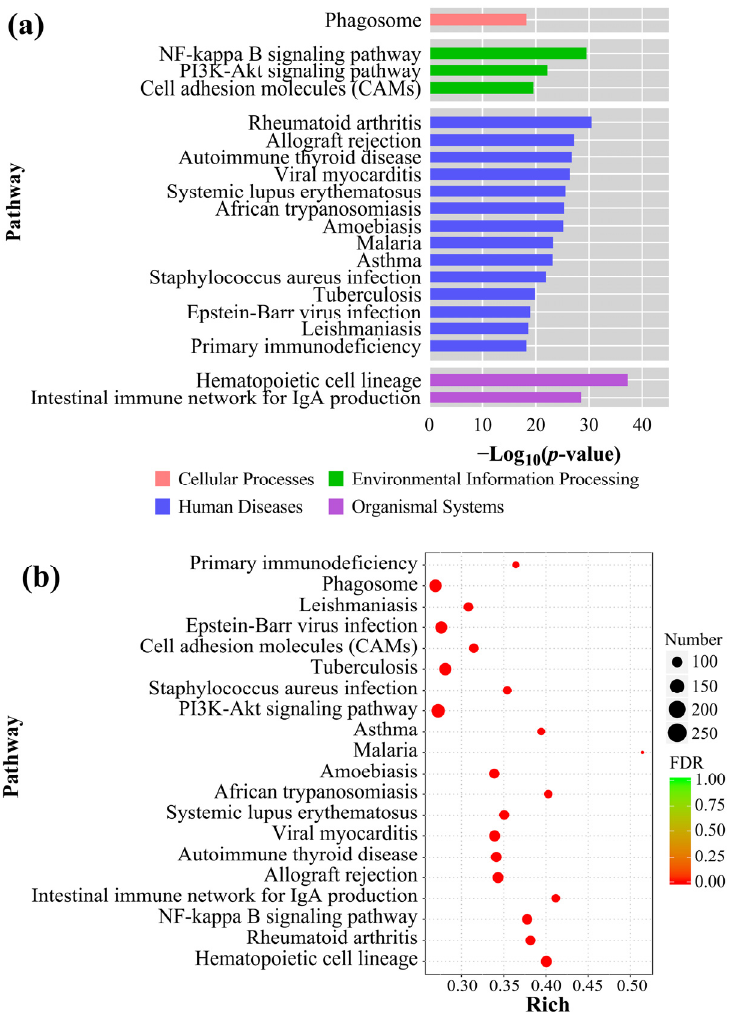
Figure 7. Classification and enrichment of DEGs mapped to KEGG pathways. ( a ) The top 20 KEGG pathways with the lowest p -value assigned in four categories. ( b ) Bubble plot of the top 20 enriched pathways based on the FDR values and the number of DEGs. The bubble size reflects the number of DEGs; the color of the bubble reflects the FDR, with a lower FDR indicating more significant enrichment.